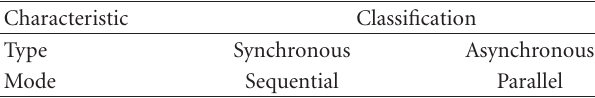
Table 2: Communication classification summary